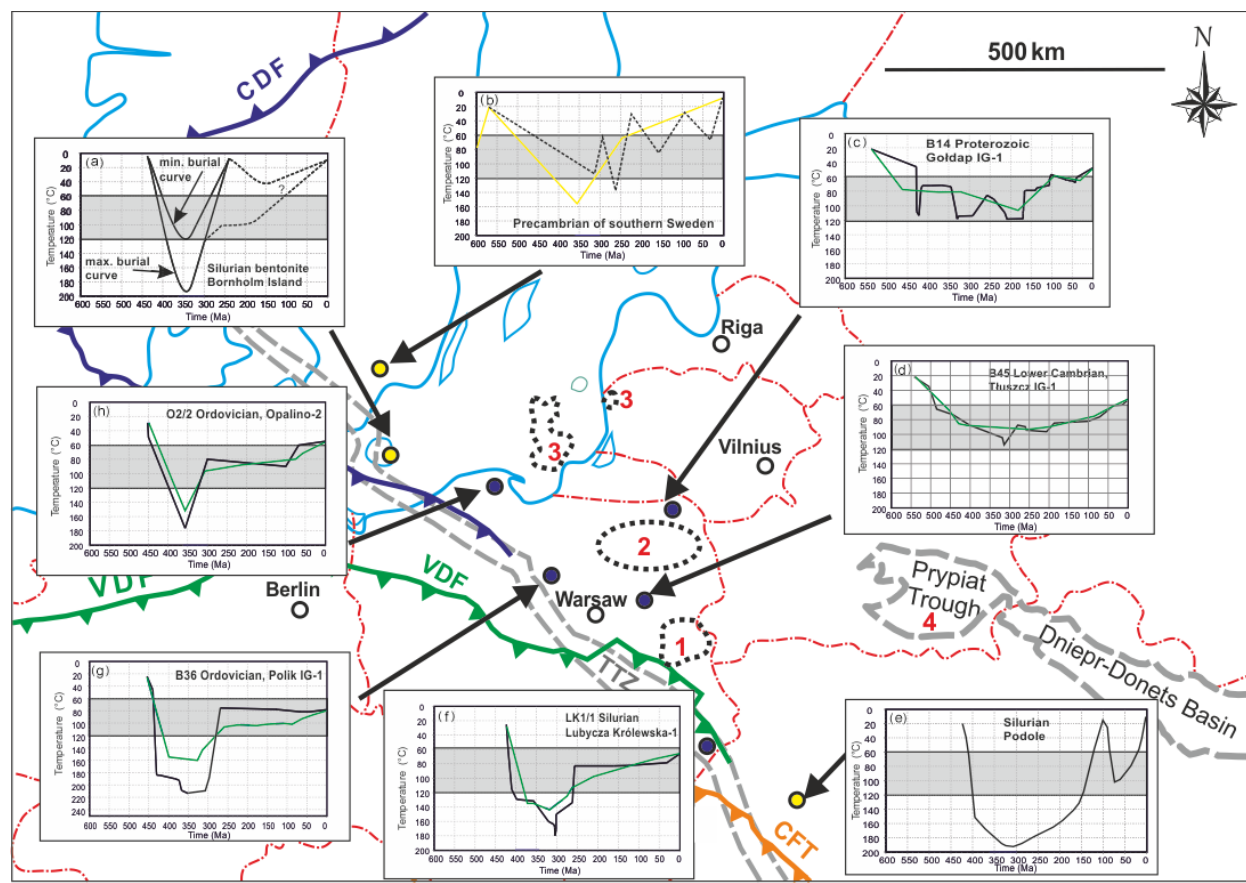
Figure 15. Simplified thermal history of different parts of the study area and adjacent regions. (a) Silurian bentonite from the island of Bornholm; dashed line shows possible options for t – T history in the Mesozoic (Hansen, 1995); (b) Precambrian of southern Sweden: dashed line from (Japsen et al., 2016), bold yellow curve form (Guenthner et al., 2017); (c) Gołdap IG-1, well this study; (d) Tłuszcz IG-1, this study, (e) Silurian bentonite from Podolia (´Srodo´n et al., 2013), (f) Lubycza Królewska-1, this study; (g) Polik IG-1 this study; (h) Opalino-2, this study. In panels (c) – (d) , (f) – (h) the black curve is the best-fit model, whereas the green curve is the average. Grey box – apatite partial annealing zone (60–120 ◦ C). Black dots show localities from this study, yellow dots – from other studies. Dotted black polygons on the map indicate the latest Devonian to early Carboniferous volcanic rocks in the study area and surroundings: (1) (Pa´nczyk and Nawrocki, 2015): 348 ± 0.8Ma, alkaline basalts; (2) (Demaiffe et al., 2013): 345–354Ma, alkaline intrusions; (3) (Motuza et al., 2015): dolerite sills 355Ma and a granite vein 349Ma; (4) (Kusznir et al., 1996): 367–364Ma rifting and magmatism. CDF – Caledonian Deformation Front; CFT – Carpathian Frontal Thrust; TTZ – Teisseyre–Tornquist Zone; VDF – Variscan Deformation